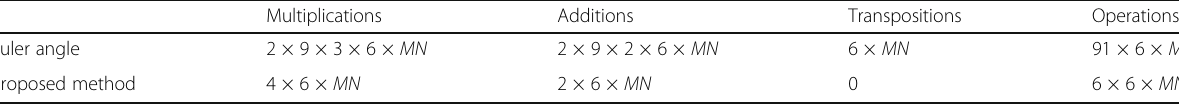
Table 2 The computational complexity of the proposed method and Euler angle